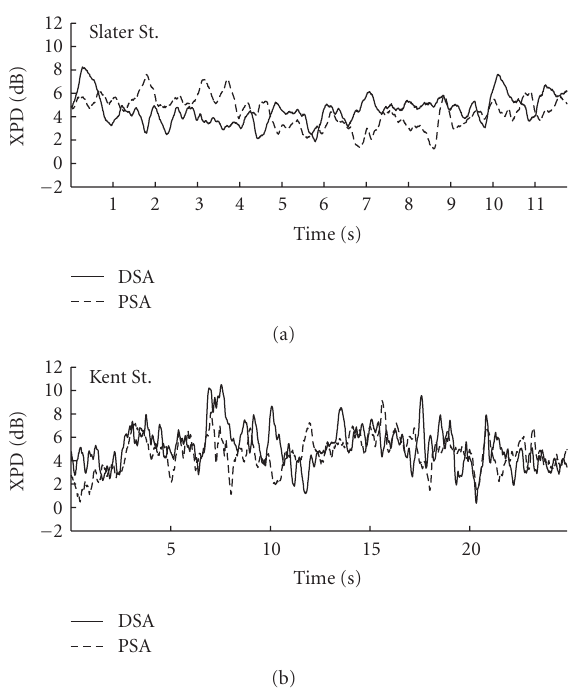
Figure 10: API measured on Slater Street (a) and Kent Street (b). after; this suggests the signal emitted from the alley is more depolarized than that propagating along Slater Street from the intersection at Kent Street.